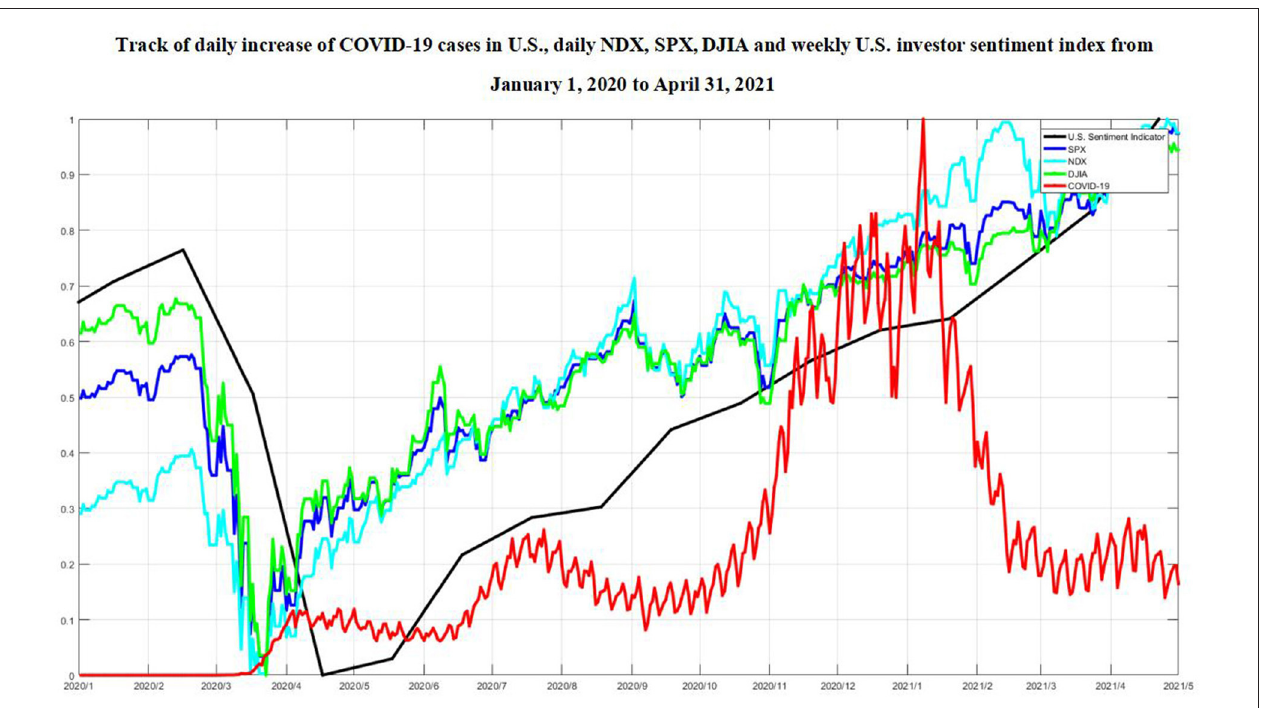
Frontiers in Public Health |